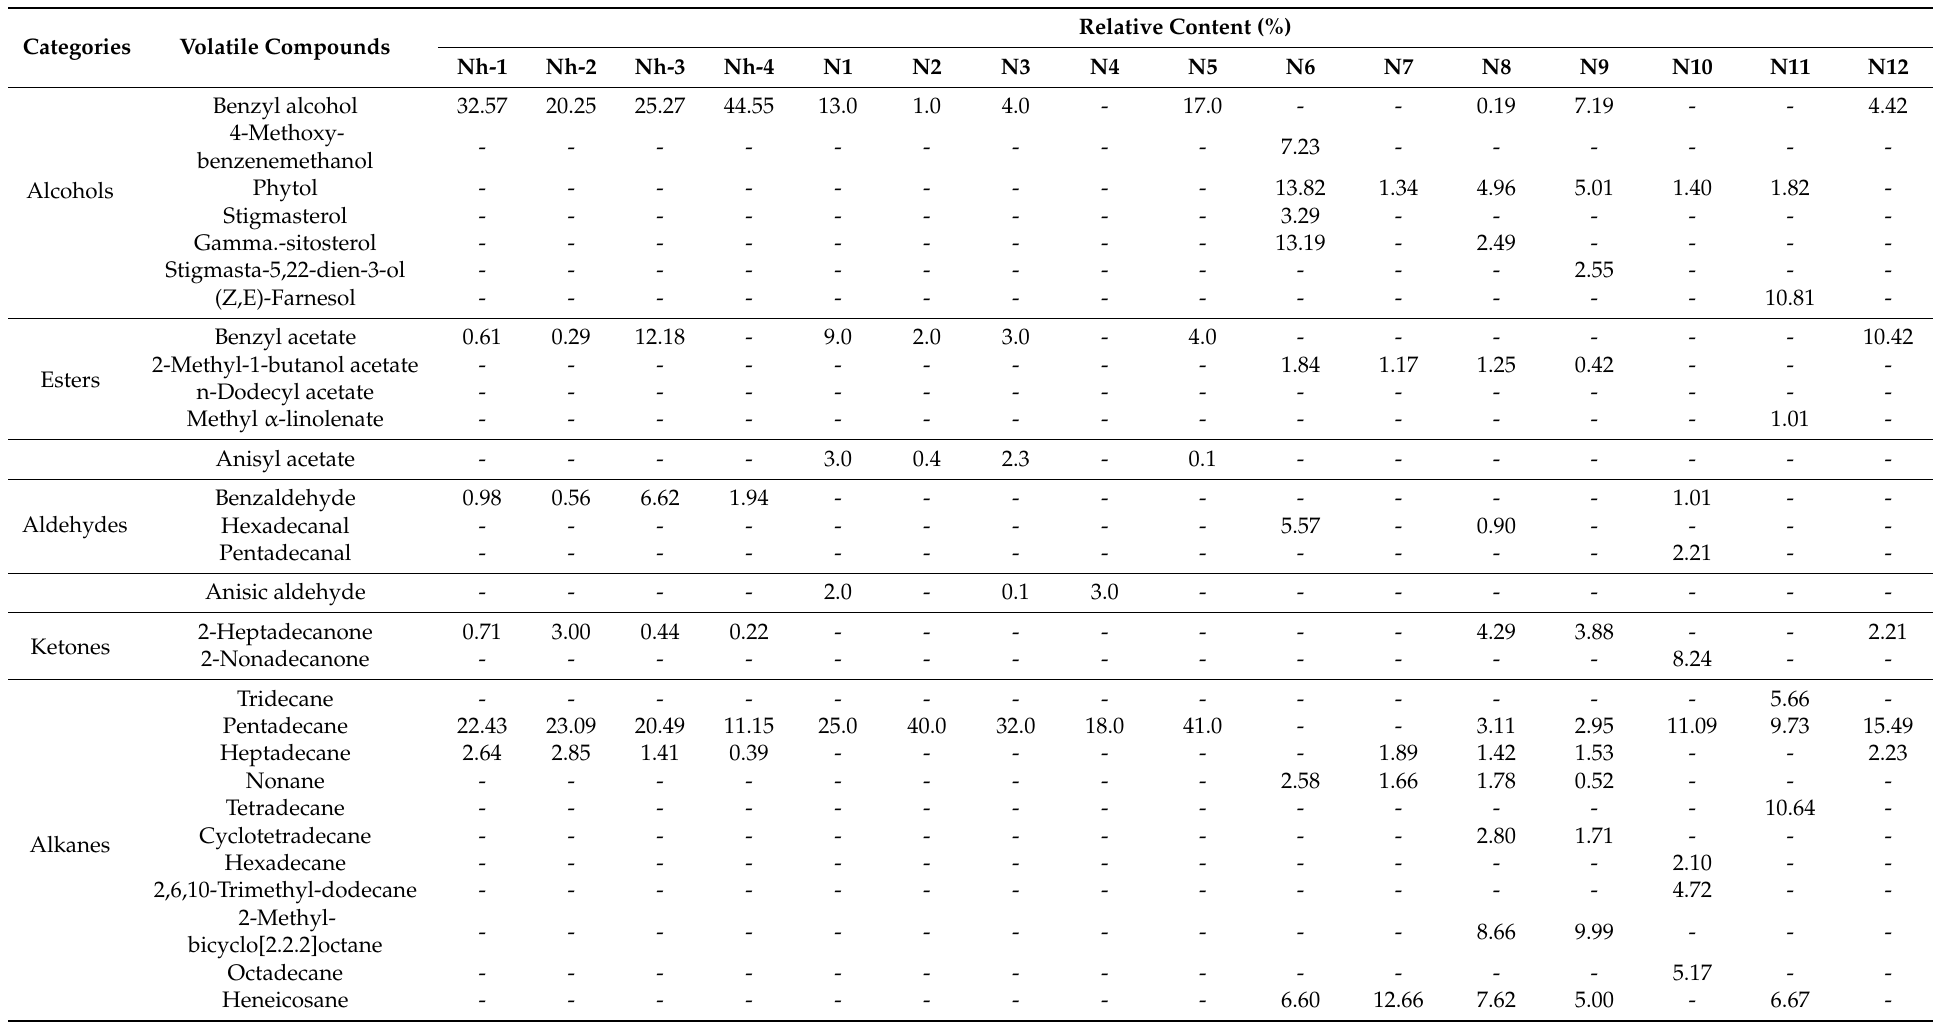
Table 4. Comparison of the main volatile compounds in different Nymphaea